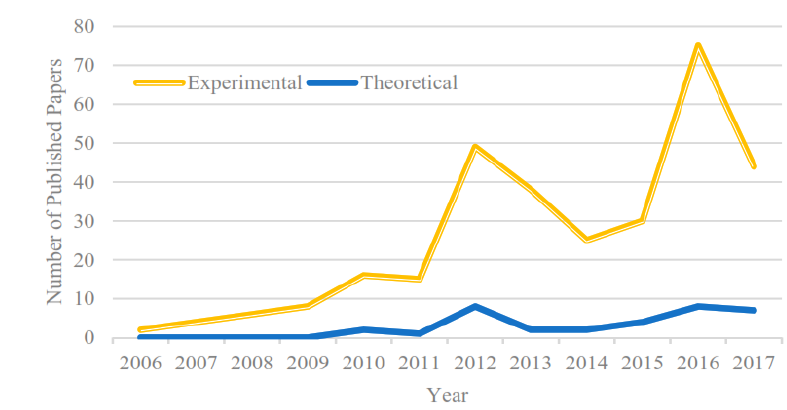
Figure 2. Research on nanotechnology application in the petroleum industry